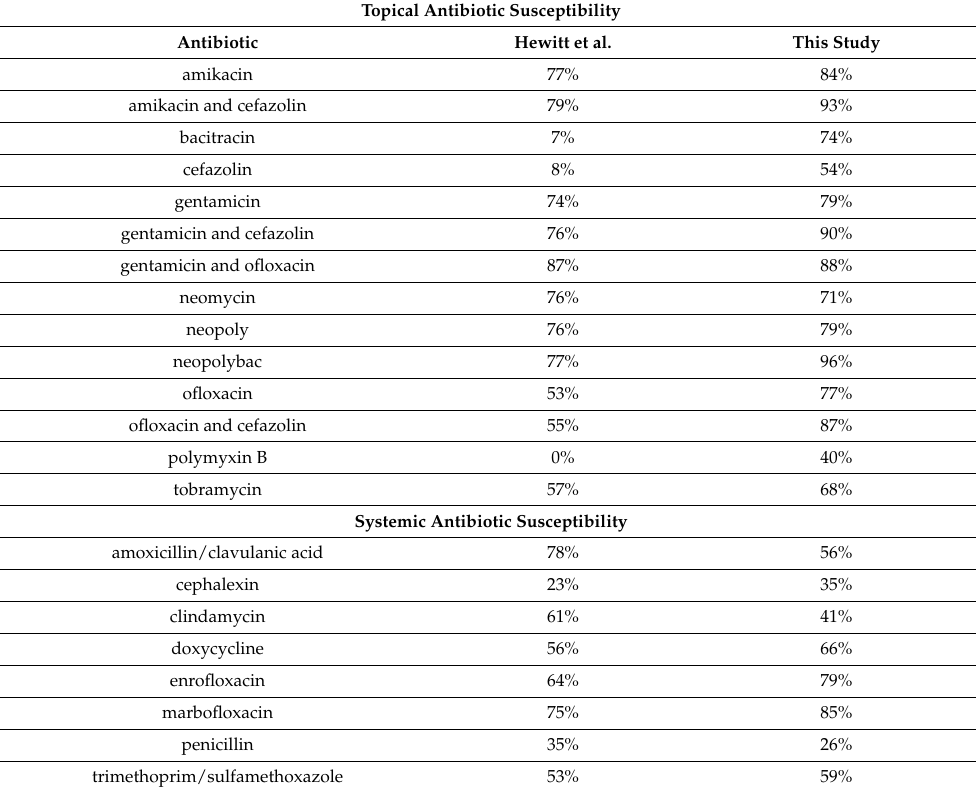
Table 5. Comparison of susceptibility profiles of isolates in the midwestern US between Hewitt et al. and this